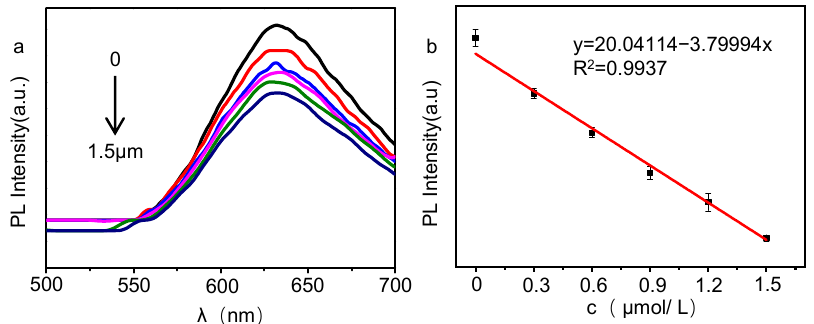
Figure 7. ( a , b ) PL intensity changes of o-GQDs at different concentrations of Al 3+